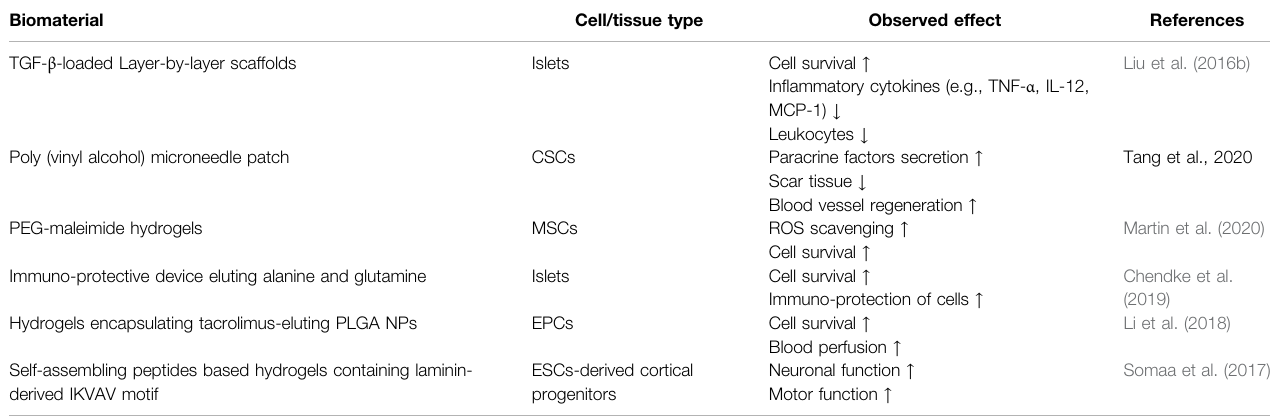
TABLE 5 | Enhancing stem cell function by modulating the injury microenvironment.